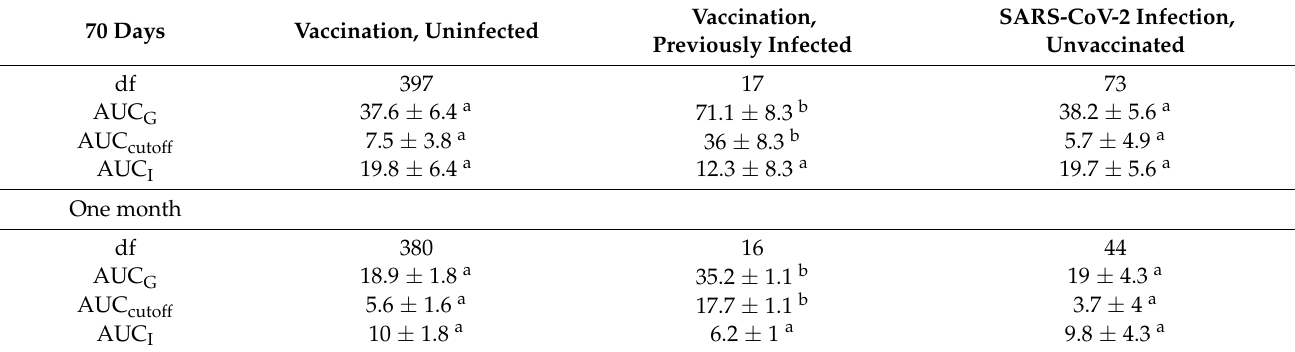
Values are in mean ± SEM. Abbreviations: SEM, standard error of the mean; df, degrees of freedom; AUC G , area under the curve with respect to ground; AUC cutoff , to IgA cutoff value set at 0.502; AUC I , to increase. a,b Different superscript letters next to AUC values indicate a significant difference. Statistical significance ( p < 0.05) was determined using a one-way ANOVA